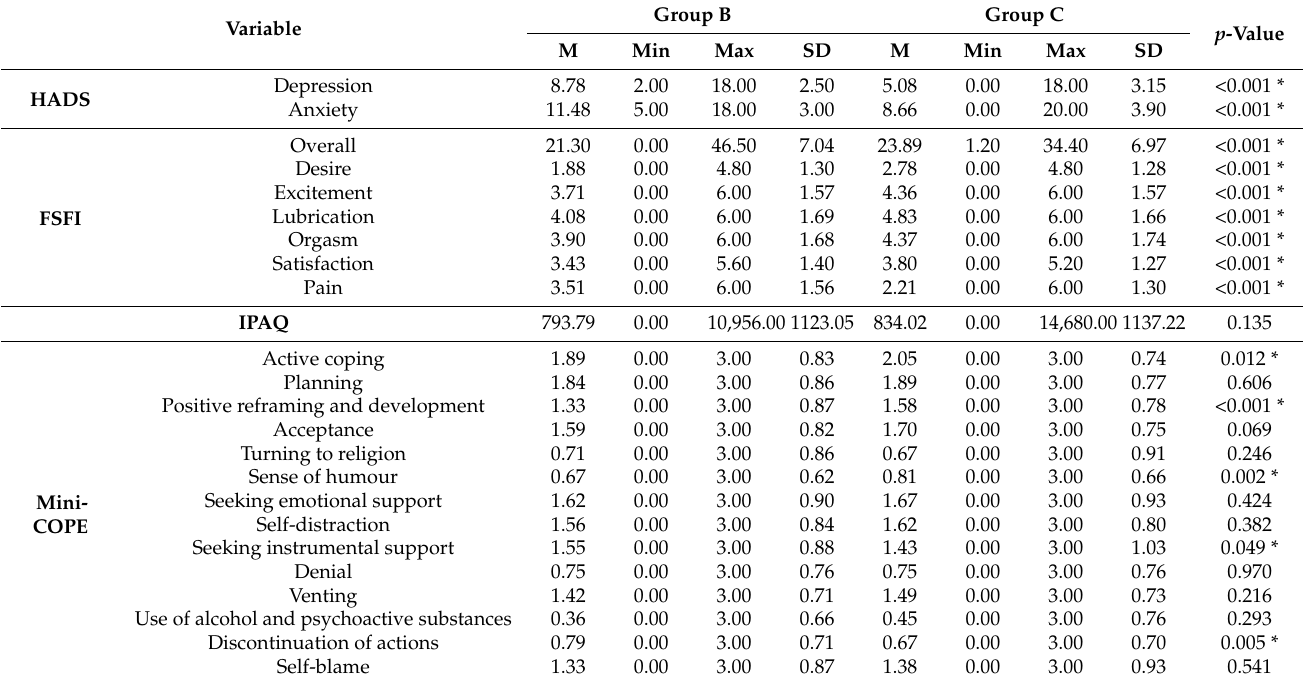
Table 3. Intergroup analysis of the results of the questionnaires: Mini-Cope, FSFI, HADS, and IPAQ. Variable